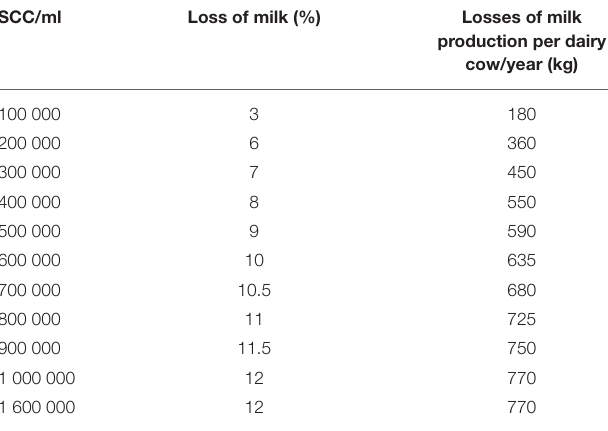
- the measures in place must be effective against all mastitis pathogens (25, 48).